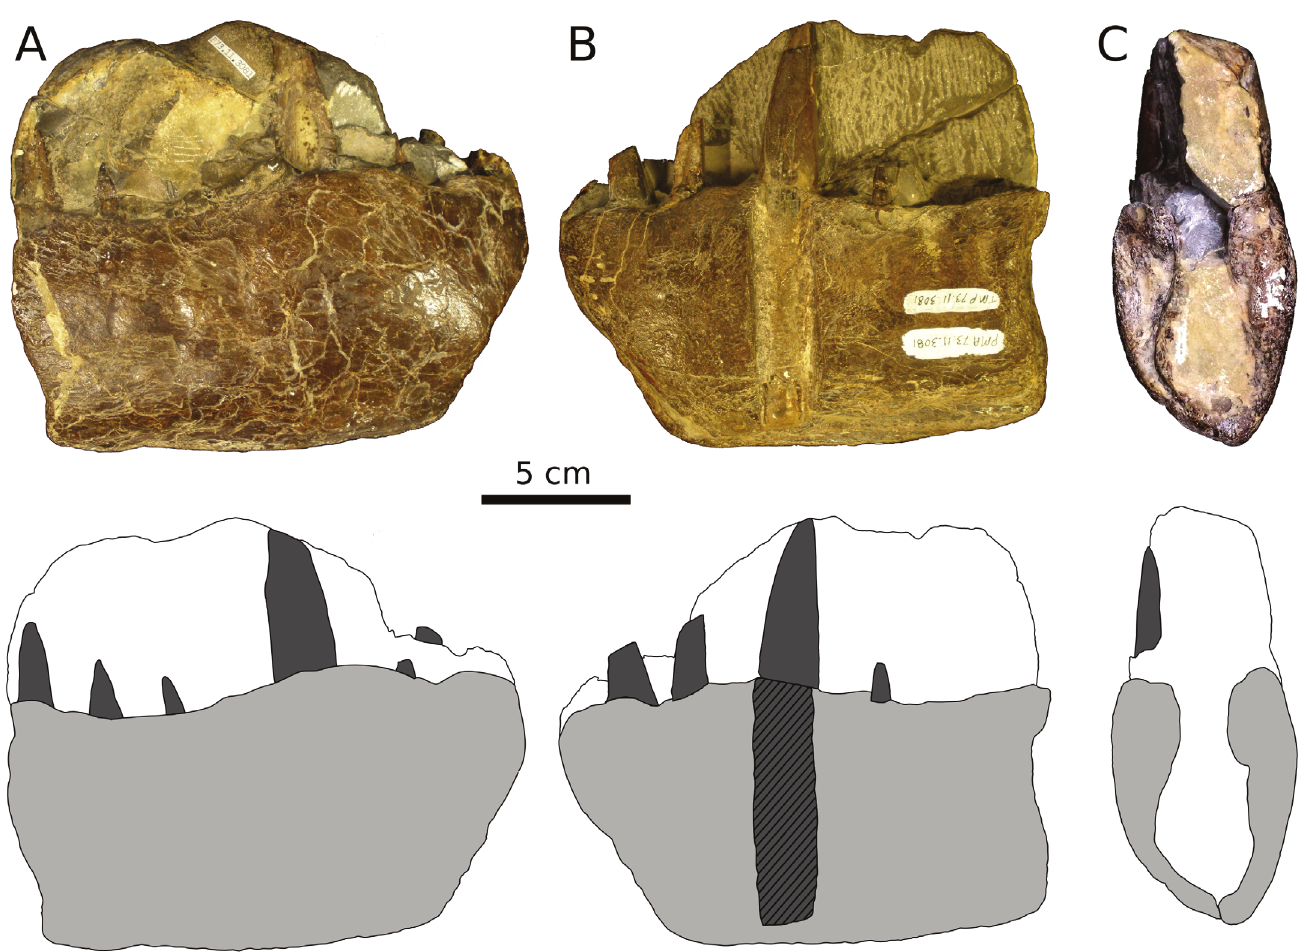
Figure 2. TMP 1973.011.3081, partial jaws of Xiphactinus audax Leidy 1870. A) Right lateral view. B) Left lateral view. C) Posterior view. For all line drawings matrix is shaded white, bone is shaded light grey, teeth are shaded dark grey, and cross-hatching indicates areas of exposed tooth